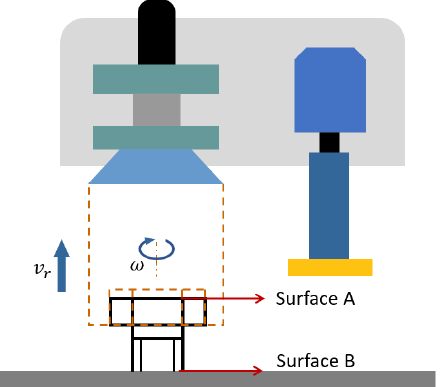
Figure 20. Unfastening motion after the